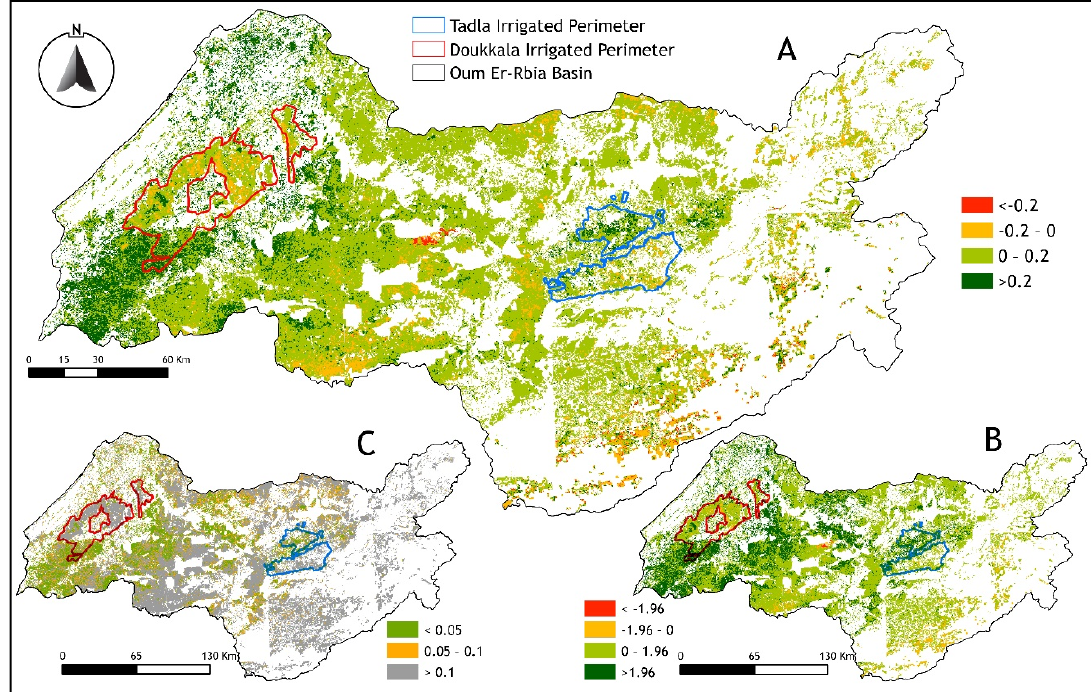
Figure 9. Spatial distribution of end of cropping season time (TEOS) trend. Maps A, B, and C represent Sen’s slope values, Kendall Z, and p-value intervals, respectively.